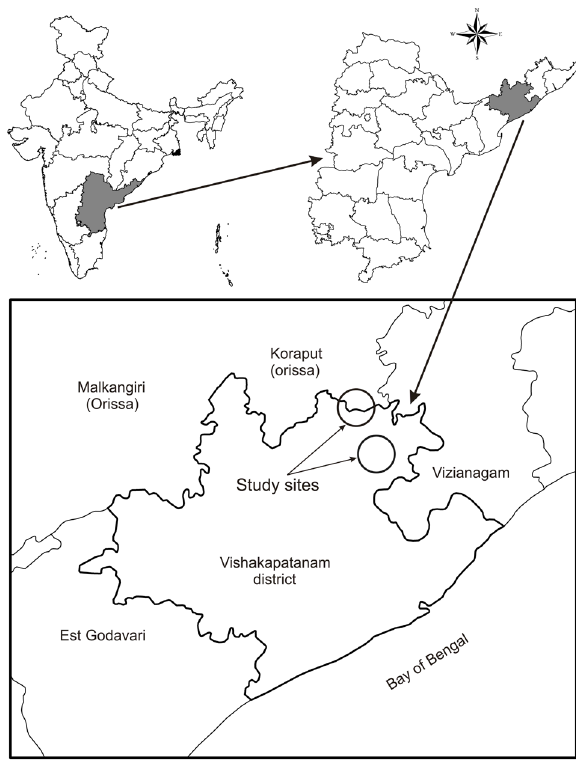
Figure 1. Map showing general location of the Araku Valley and intensive survey